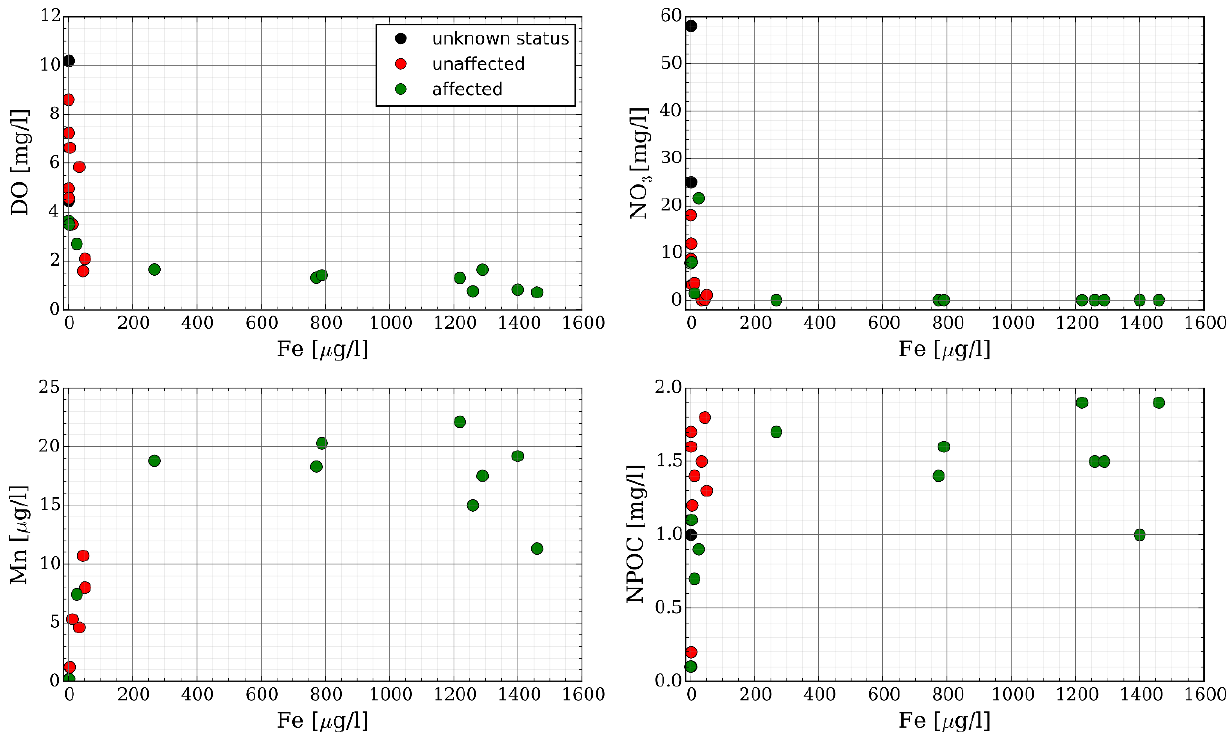
Figure 3. Correlations of Fe with redox sensitive species: dissolve oxygen (DO), nitrate (NO 3− ), and manganese (Mn). Additionally, shown is the correlation of Fe 2+ and organic matter concentrations. Green symbols relate to clogging-affected bores, red symbols represent unaffected bores, while black symbols relate to bores where the severity of clogging was unknown.